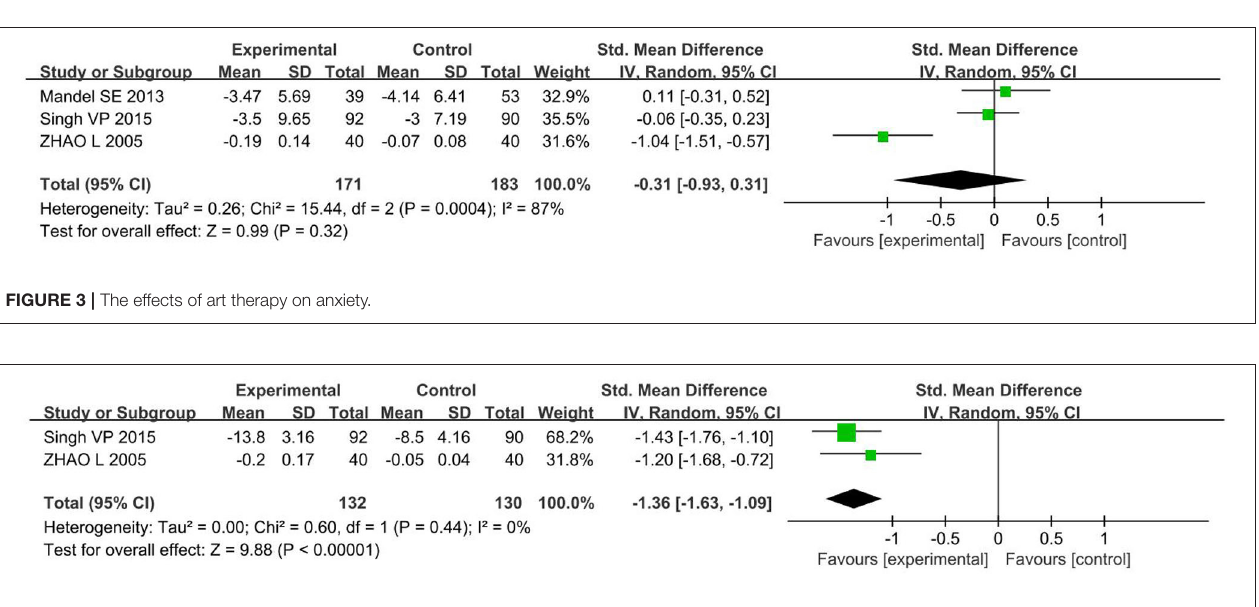
FIGURE 4 | The effects of art therapy on